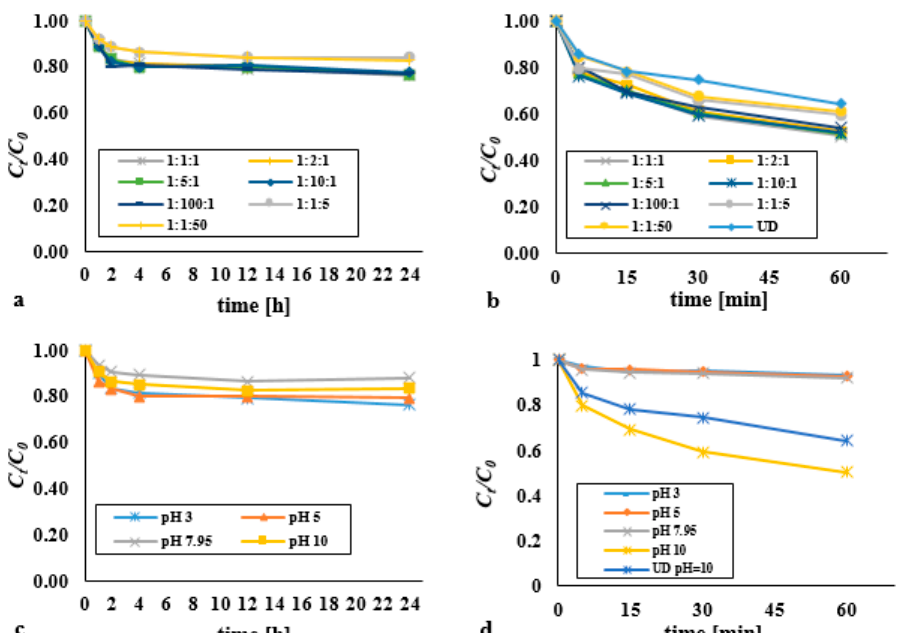
Figure 2. Impact exerted on the decomposition of DEHP where use is made of: ( a ) a Fenton process with various dosages (at pH 3); ( b ) a Fenton process with various dosages supported by an ultrasonic field (pH = 10, acoustic wave intensity = 3.97 W/cm 2 ); ( c ) a Fenton process in various pH (molar ratio DEHP:H 2 O 2 :Fe 2+ 1:1:1); ( d ) Fenton process assisted by ultrasonic field in various pH